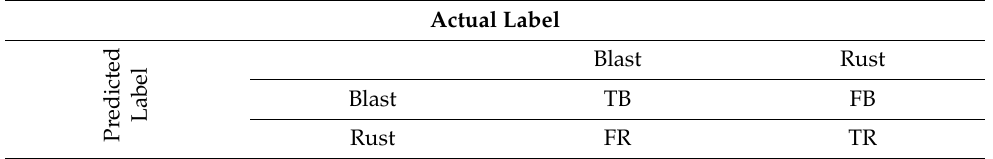
Table 3. Sample Confusion matrix.